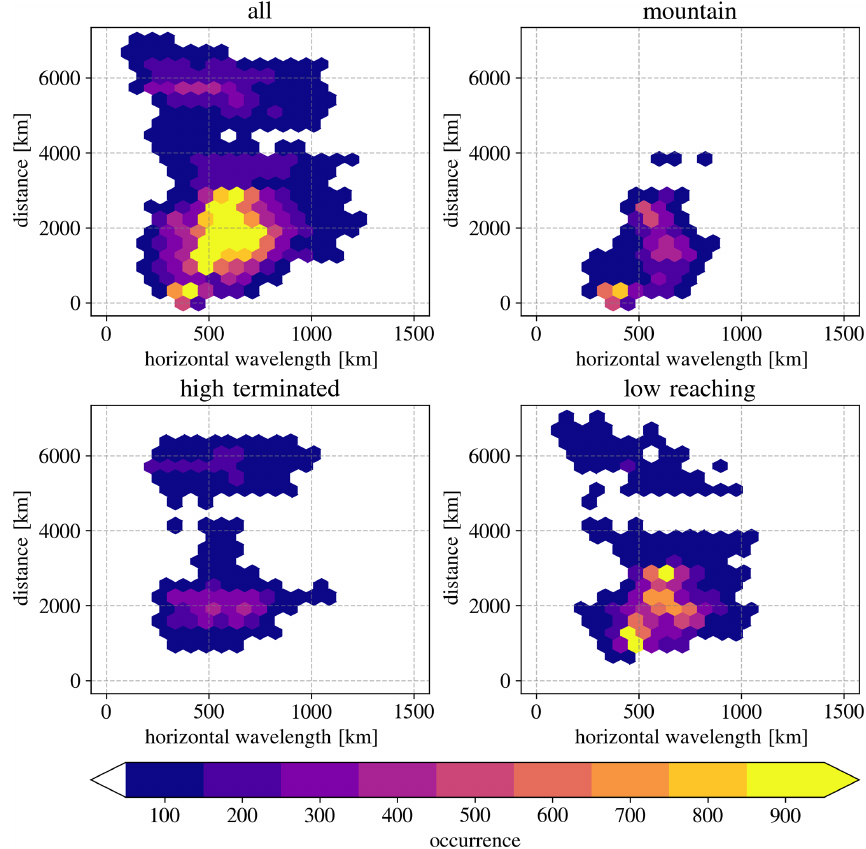
Figure 9. Same as Fig. 8 but for the horizontal wavelength on the x